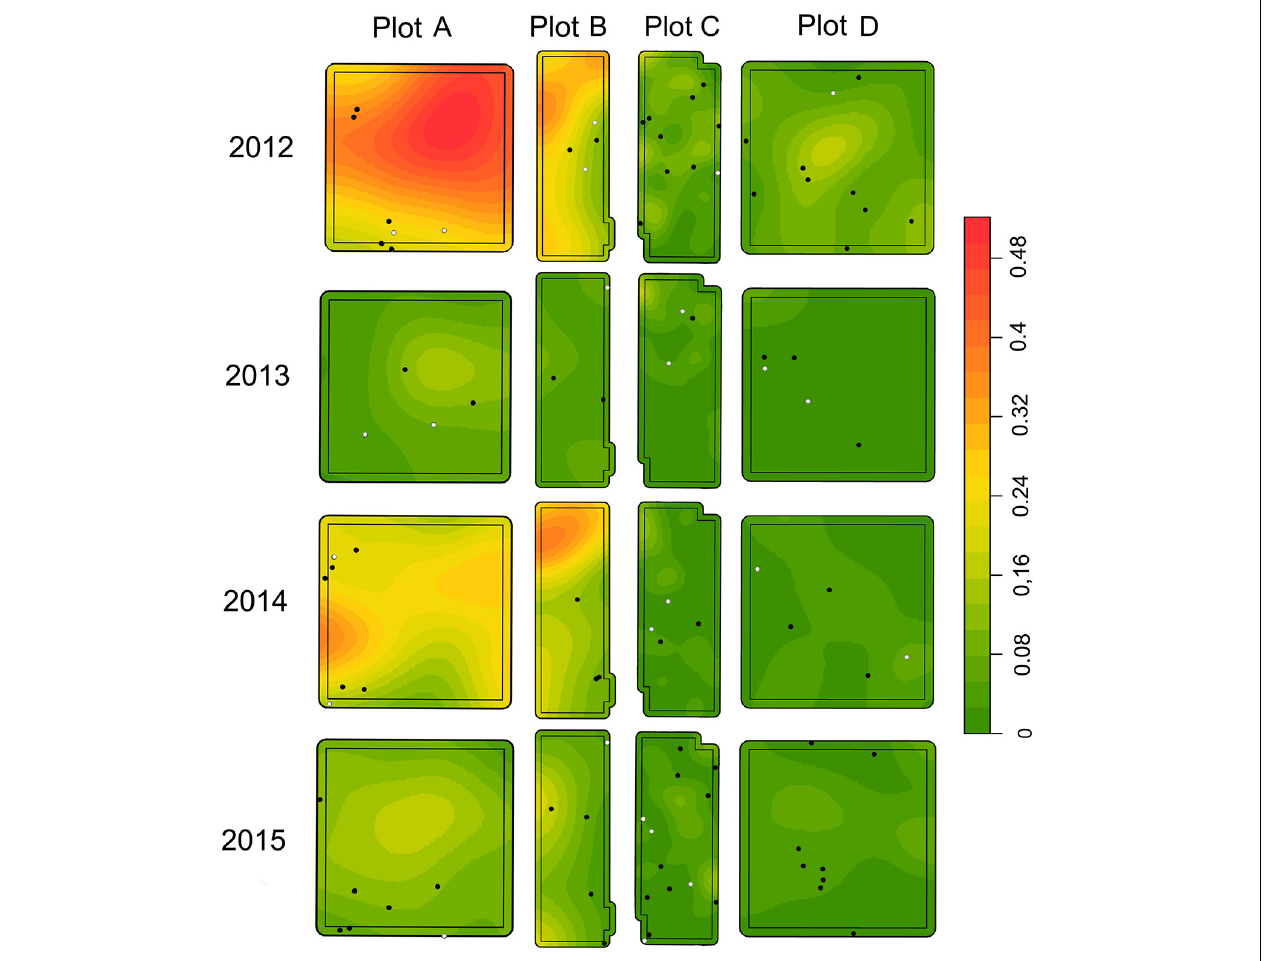
FIGURE 1 | Spatiotemporal variability in Eastern Chipmunk activity. Kernel densities of eastern chipmunk detections (expressed as number of detections per hectare) in each study plot (25 ha) and year. Note that plot size was adjusted to allow direct comparisons. Black and white dots represent the locations of Ovenbird and Hermit Thrush nests,